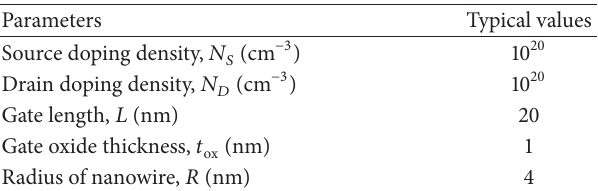
Table1:Typicaldeviceparametersusedinthesimulationandmodel